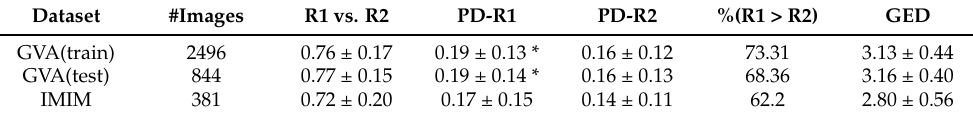
Table 4. Percent density (PD) and generalized energy distance (GED) for CM-YNet (mask).